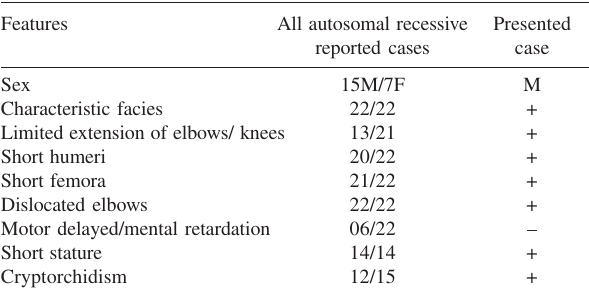
Table 1 – Main features of the reported autosomal recessive cases